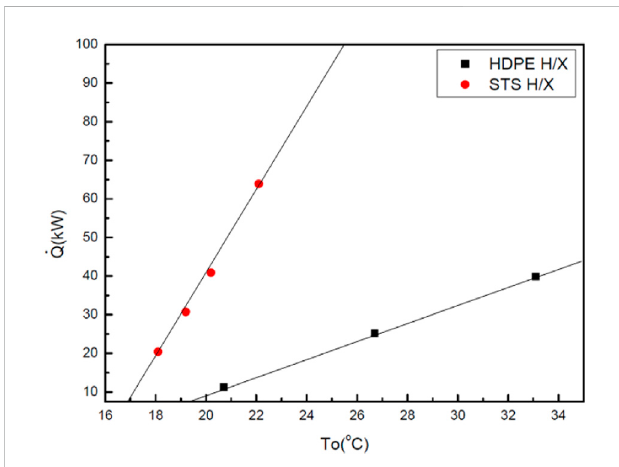
FIGURE 5 Variations of the thermal capacity with T o of circulating